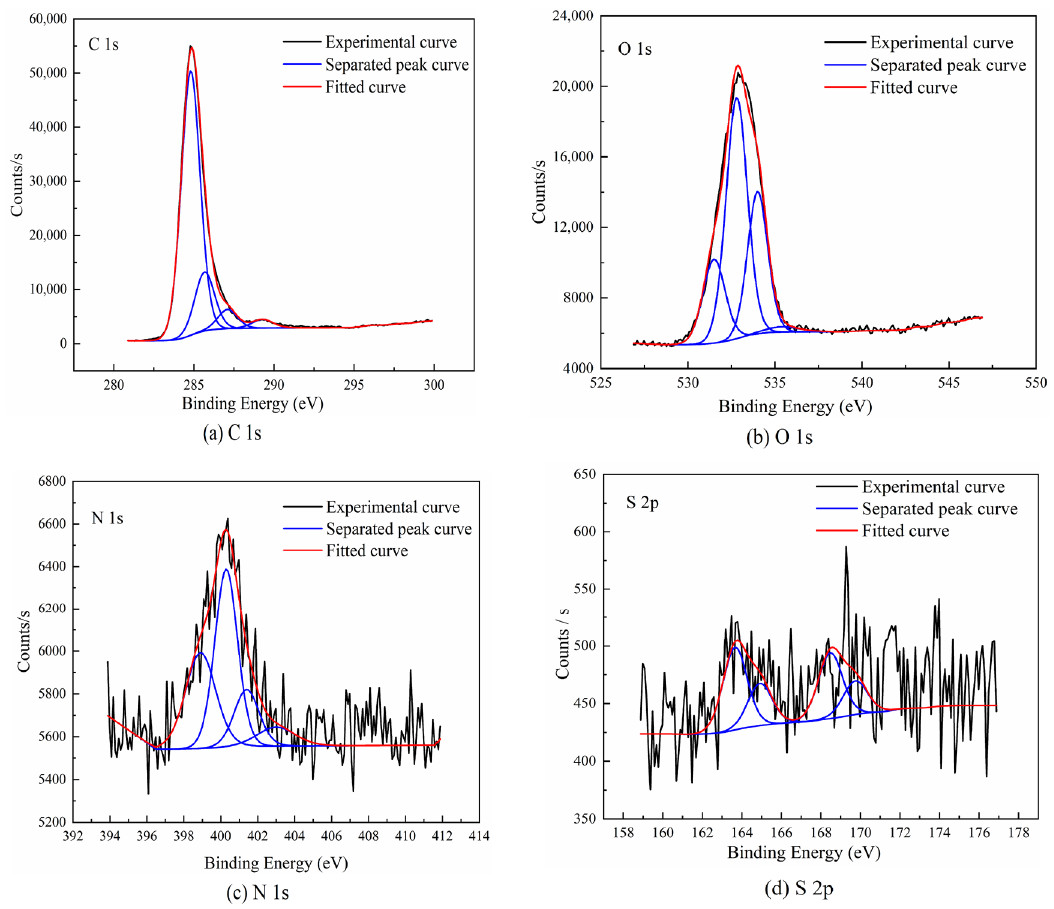
Figure 2. XPS spectra of Kerjian coal with C, O, N and S elements.